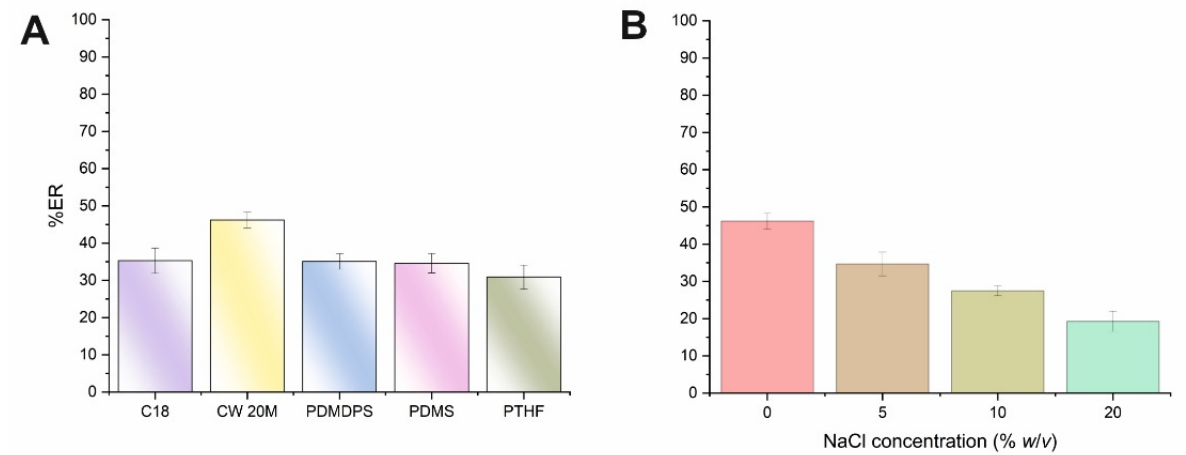
Figure 1. Effect of the ( A ) CPME sorbent type and ( B ) ionic strength (expressed as NaCl concentra- tion,% w / v ) on the ER% of AMB.